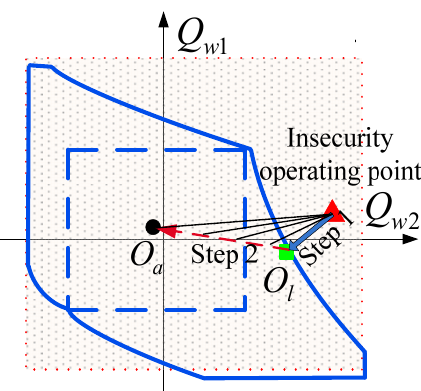
Figure 1. A two-step optimal adjustment strategy for